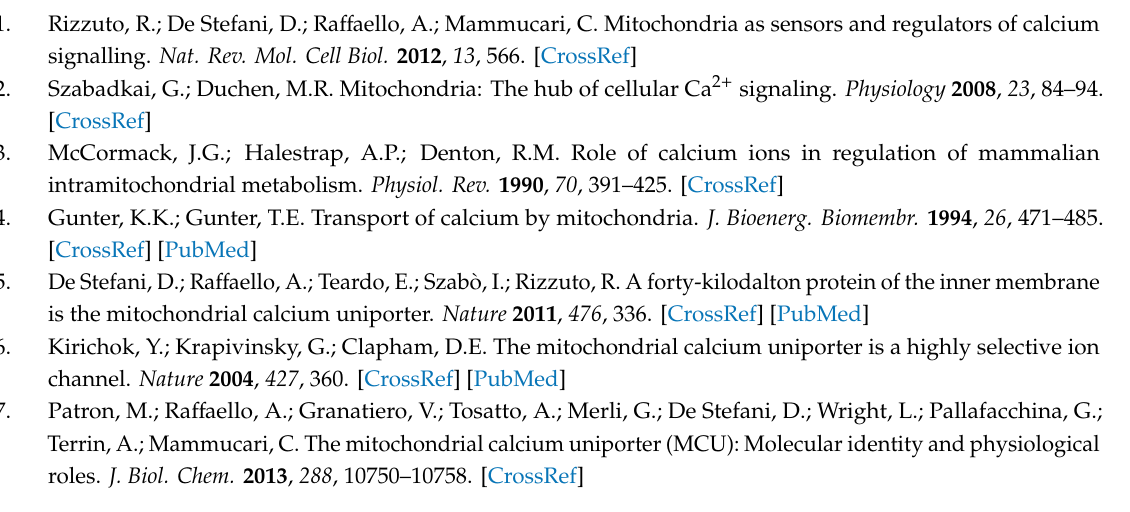
concentration in the microdomain ([Ca 2 + ] mic ) due to the opening of a single IP 3 R as a function of distance from the channel, Figure S6: Changes in mitochondrial variables in response to the opening of a single IP 3 R channel at the single mitoplast level, Figure S7: The behavior of the three reactions controlling [NADH] M , Figure S8: Changes in [Ca 2 + ] M in response to the opening of a single IP 3 R channel at the single mitochondrion level as we vary the concentration of Ca 2 + bu ff er in the cytoplasm, Figure S9: Changes in [Ca 2 + ] M and [ATP] M in response to the opening of a single IP 3 R channel at the single mitochondrion level as we vary the concentration of Ca 2 + bu ff er in the cytoplasm in MICU1 KO cells, Table S1: Meaning and values of various parameters used in the bioenergetics model., Table S2: Values of various parameters given by the fit of the kinetic model for MCU function to the observed open probability of MCU as a function of [Ca 2 + ] C and [Ca 2 + ] M , Table S3: Values of various probability flux parameters given by the fitting the model to open dwell-time distribution of